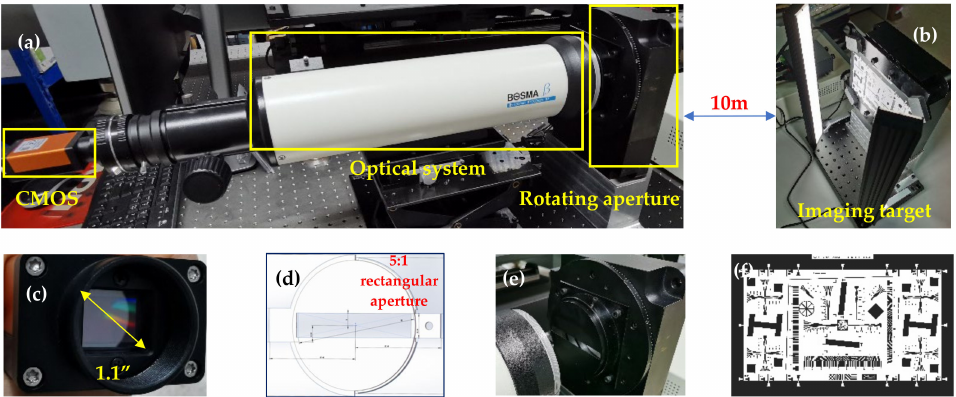
Figure 12. ( a , b ) Structure of the RRA prototype. It consists of four parts: the CMOS sensor, the optical system, the rotating aperture device, and the imaging target. The object’s distance is 10 meters. The target is illuminated with two LED linear light sources. ( c ) A front view of the 1.1 inch CMOS sensor. ( d ) Design drawing of a 5:1 aspect ratio rectangular aperture slice. ( e ) Zoomed rotating aperture device. ( f ) The ISO12233 imaging target.